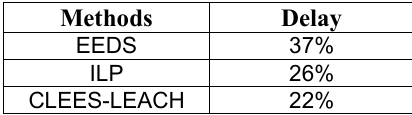
Figure 14. Network Density versus Latency